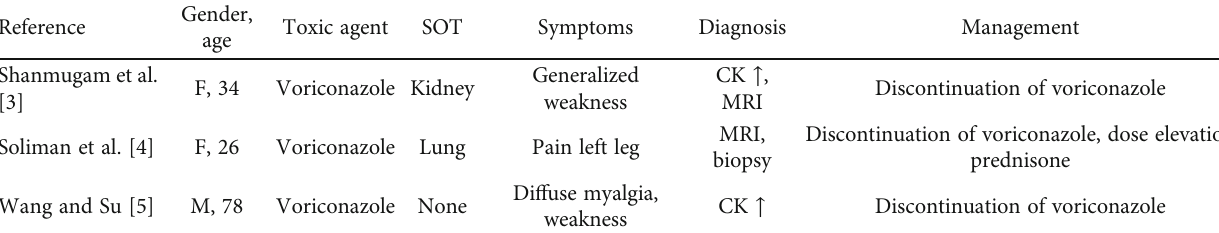
Table 3: Overview of previously reported